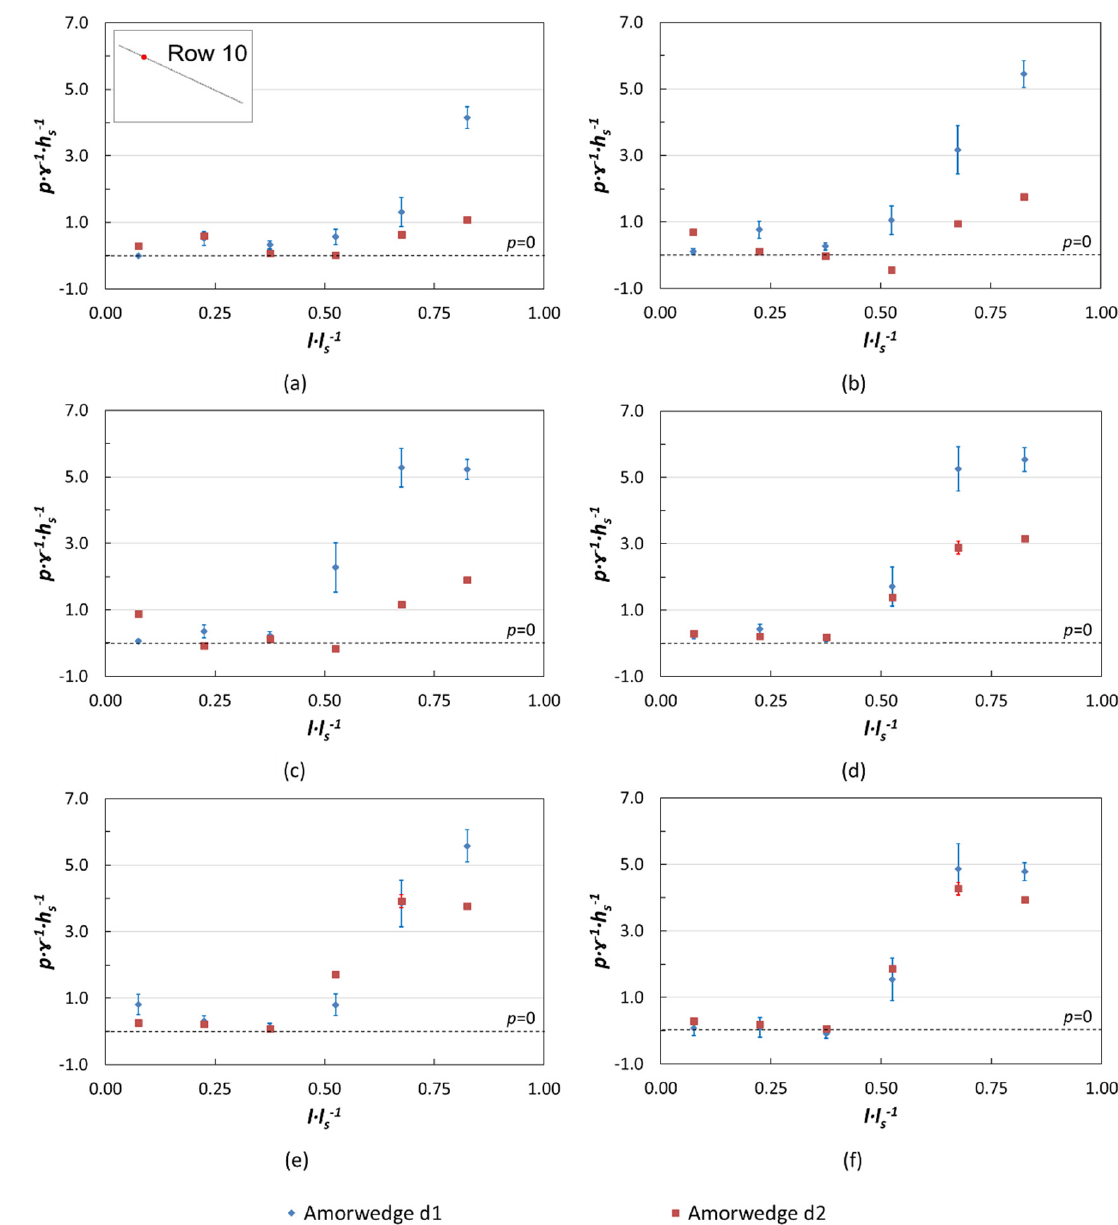
Figure 13. Average and standard deviation of the hydrodynamic pressures registered on the tread of Amorwedge TM block ( w 1) in row 10 of the chute in different drainage conditions: free drainage, d1 , and gravel drainage layer, d2 , with unit flow: ( a ) 0.04 m 2 s − 1 , ( b ) 0.08 m 2 s − 1 , ( c ) 0.10 m 2 s − 1 , ( d ) 0.12 m 2 s − 1 , ( e ) 0.16 m 2 s − 1 and ( f ) 0,20 m 2 s − 1 .